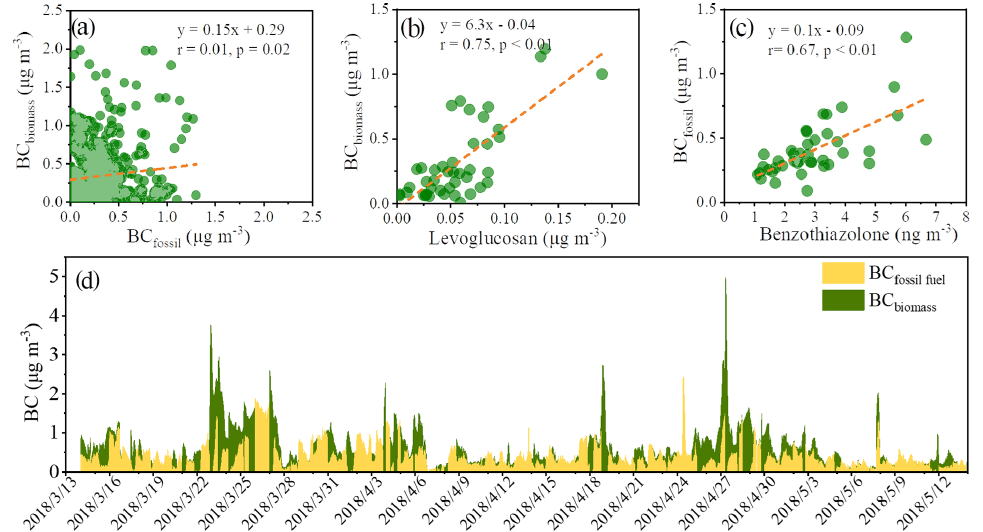
Figure 3. Scatterplots of (a) biomass-burning black carbon (BC biomass ) versus fossil fuel combustion BC (BC fossil ), (b) BC biomass versus levoglucosan and (c) BC fossil versus benzothiazolone. (d) Time series of hourly averaged mass concentrations of BC biomass and BC fossil